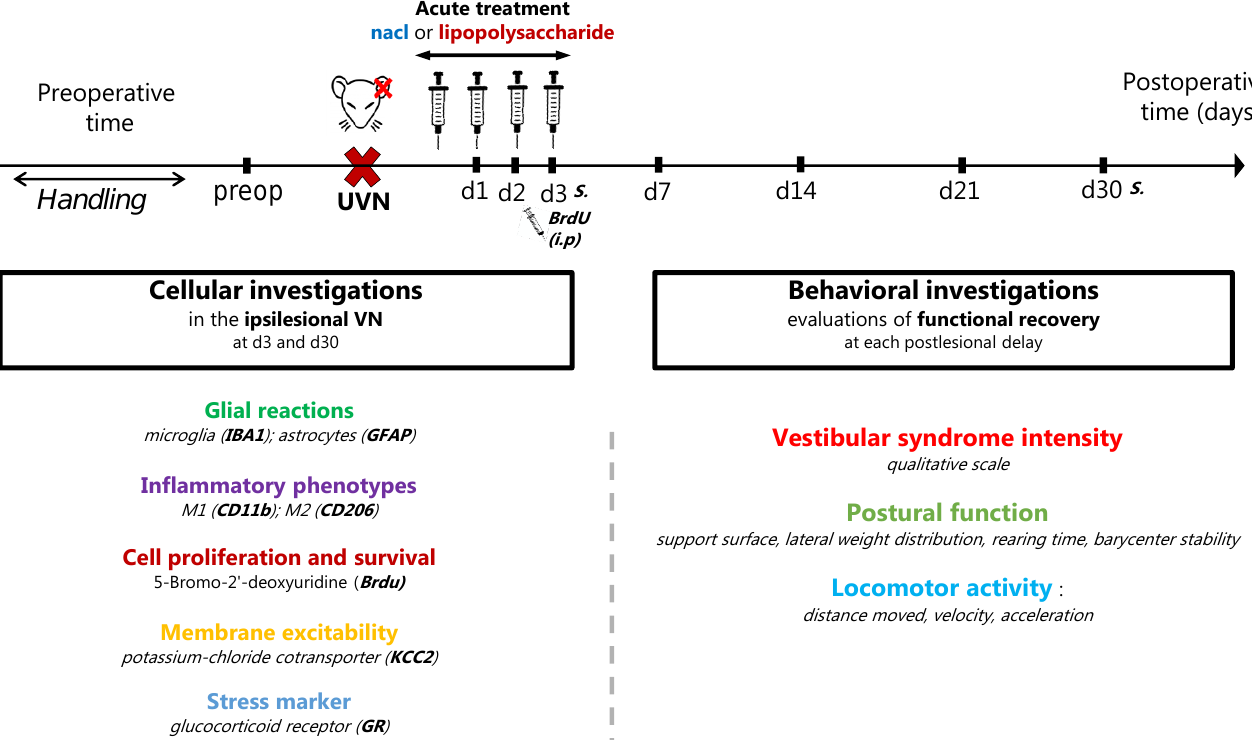
Figure 1. Study design. Experimental protocol used to study the effects of acute LPS injection follow- ing unilateral vestibular neurectomy (UVN) on vestibular compensation. Pharmacological